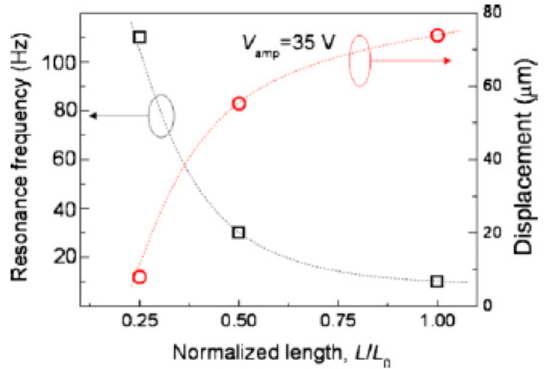
Figure 9. Comparison of the resonance frequency and the bending displacement as a function of the normalized length of the unimorph EAPap actuator for haptic applications [98].